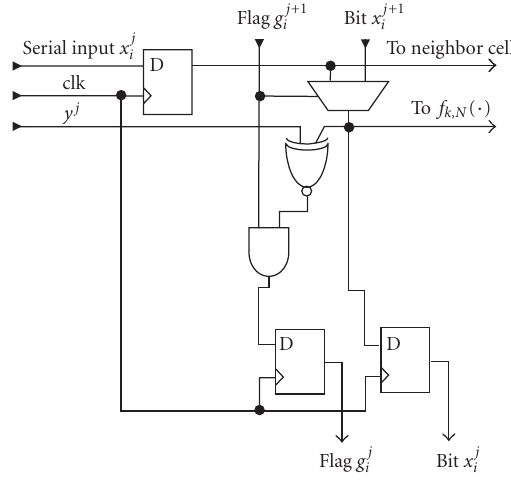
Figure 6: Pipelined version of the LUM smoother propagation